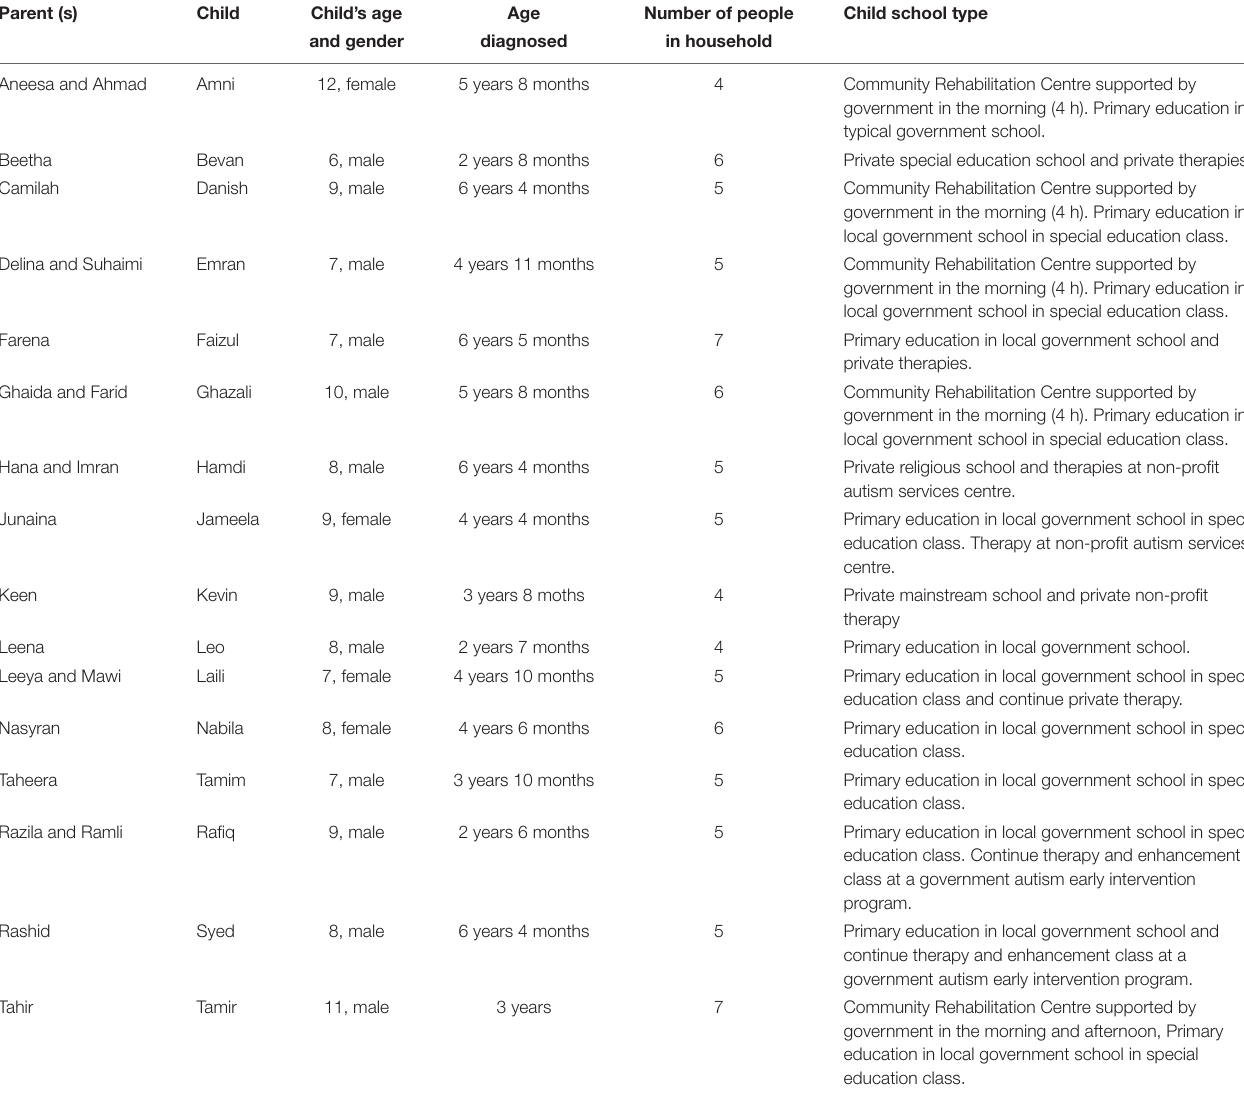
TABLE 2 | Details of child with ASD for each